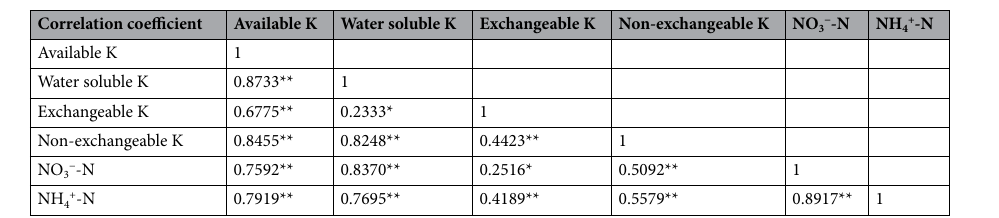
Table 8. Correlations between different forms of soil K and N. * P < 0.05; ** P < 0.01.